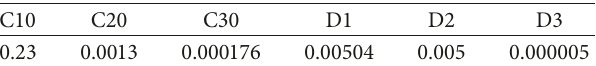
Table 3: Table of parameters of the Yeoh model for rubber